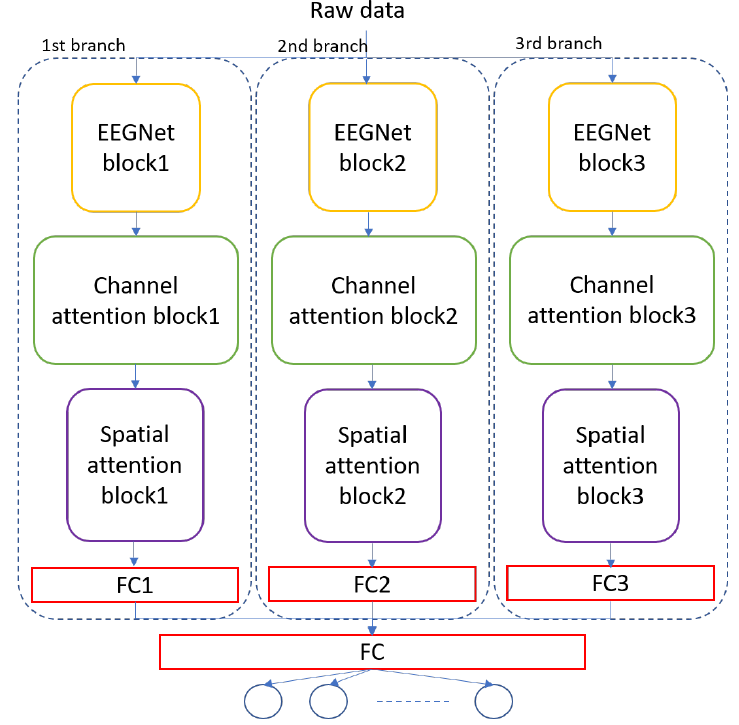
Figure 5. Architecture of the proposed model, MBEEGCBAM.